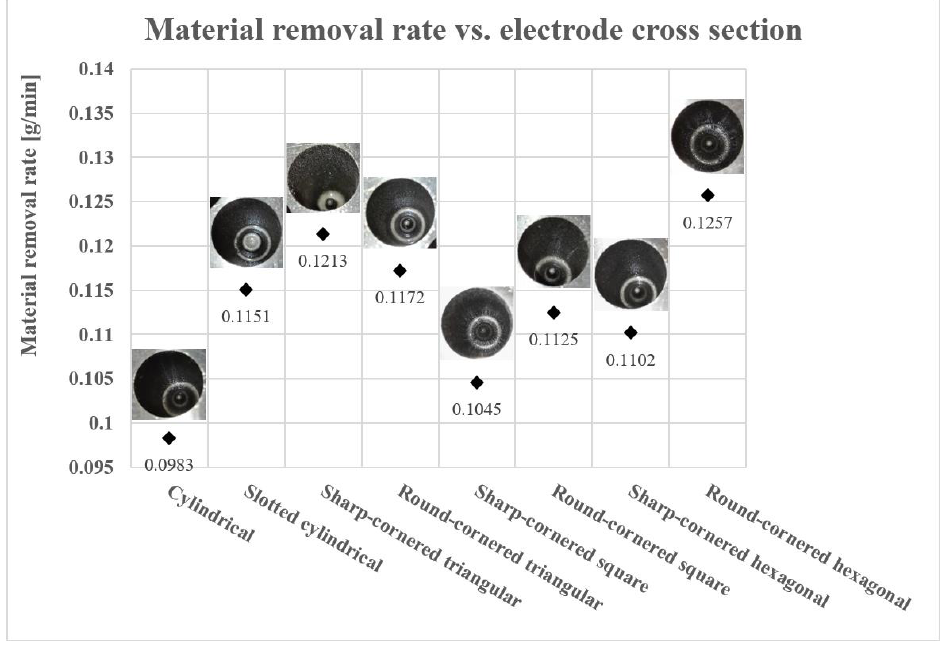
Figure 12. The Material Removal Rate (MRR) for different shaped electrodes.